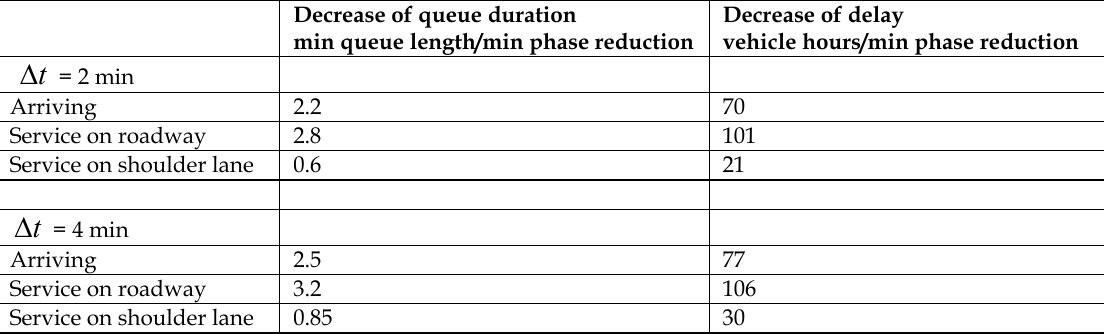
Table 6. The effectiveness of shortening the actions in Incident